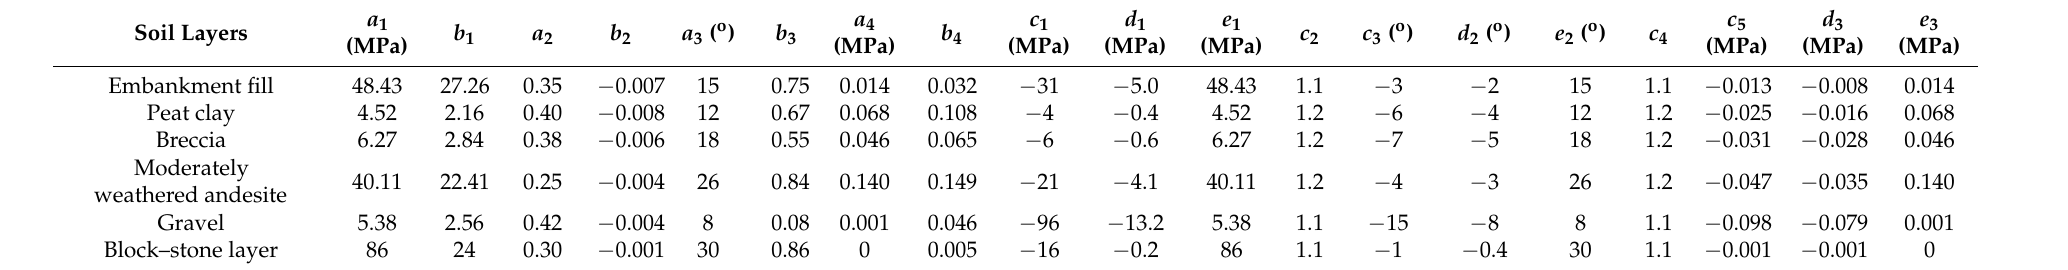
Table 3. Mechanical parameters of the soil